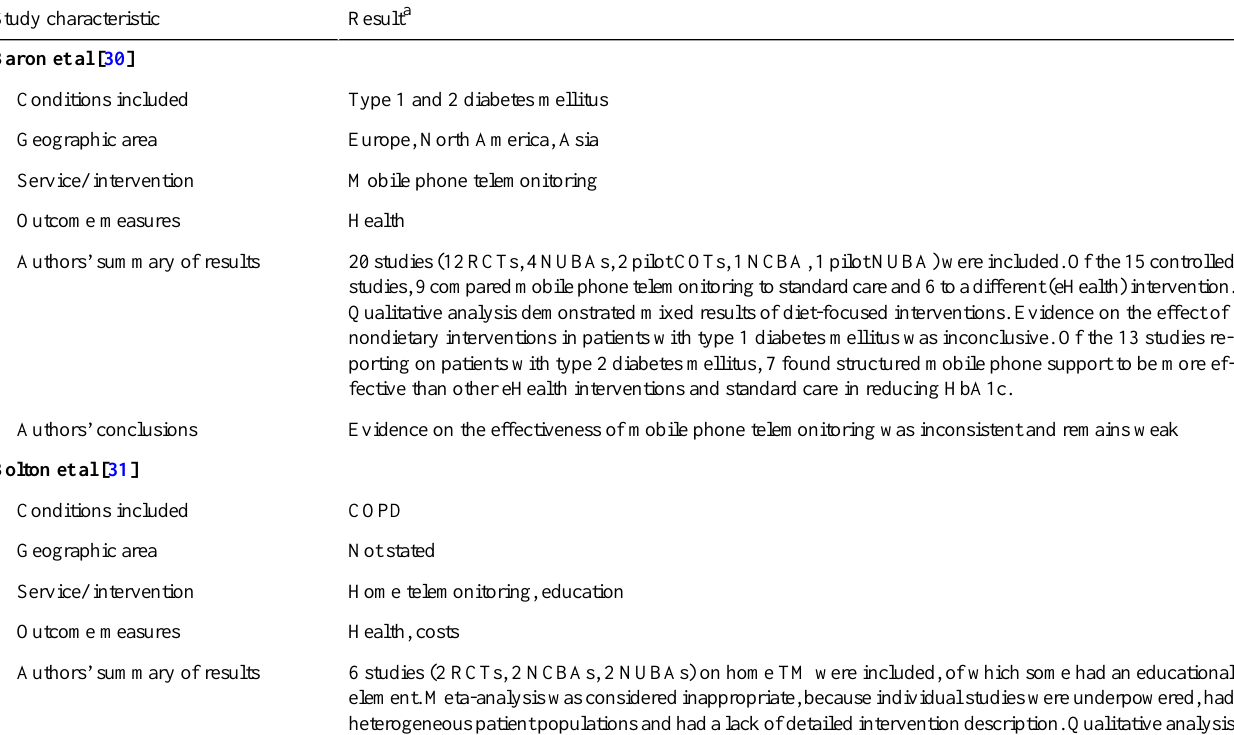
Table 5. Systematic reviews and meta-analyses in which no, limited, or inconsistent evidence on the effectiveness/cost-effectiveness of eHealth interventions was